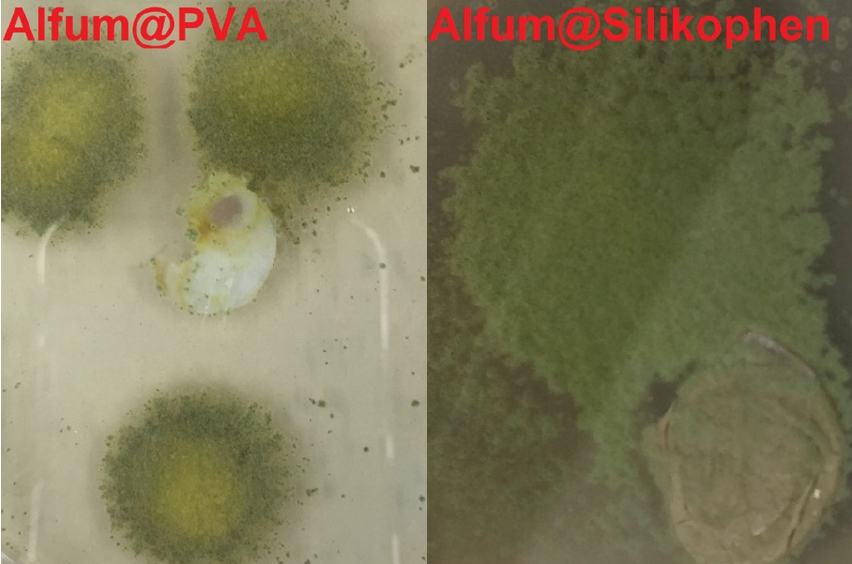
Figure 12. Pictures of the Alfum@PVA and Alfum@Silikophen ® materials in the fungus test with Aspergillus falconensis . (Visual naked-eye observations).